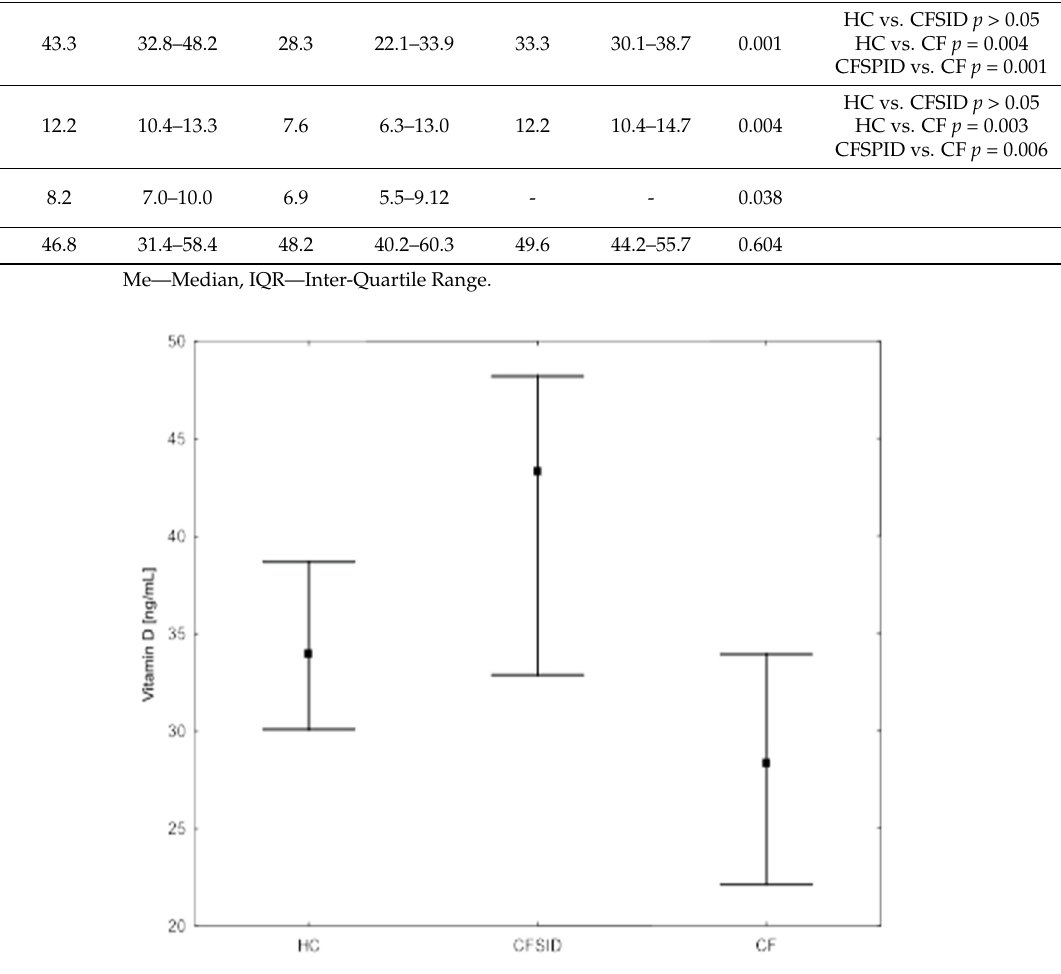
Figure 1. Vitamin D blood concentration among CF, CFSPID, and HC.